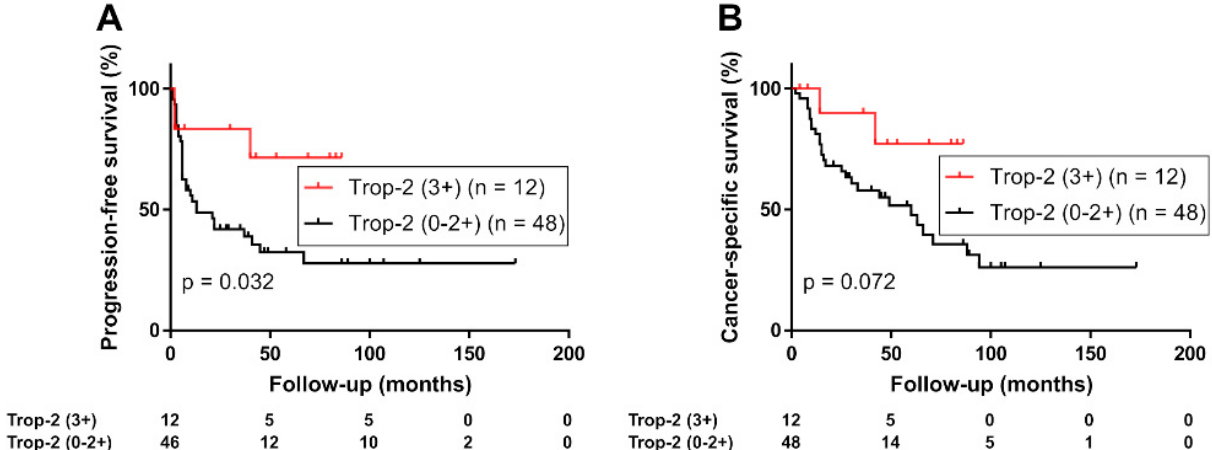
tract urothelial carcinoma stratified using expression of trophoblast cell surface antigen 2 (Trop-2,